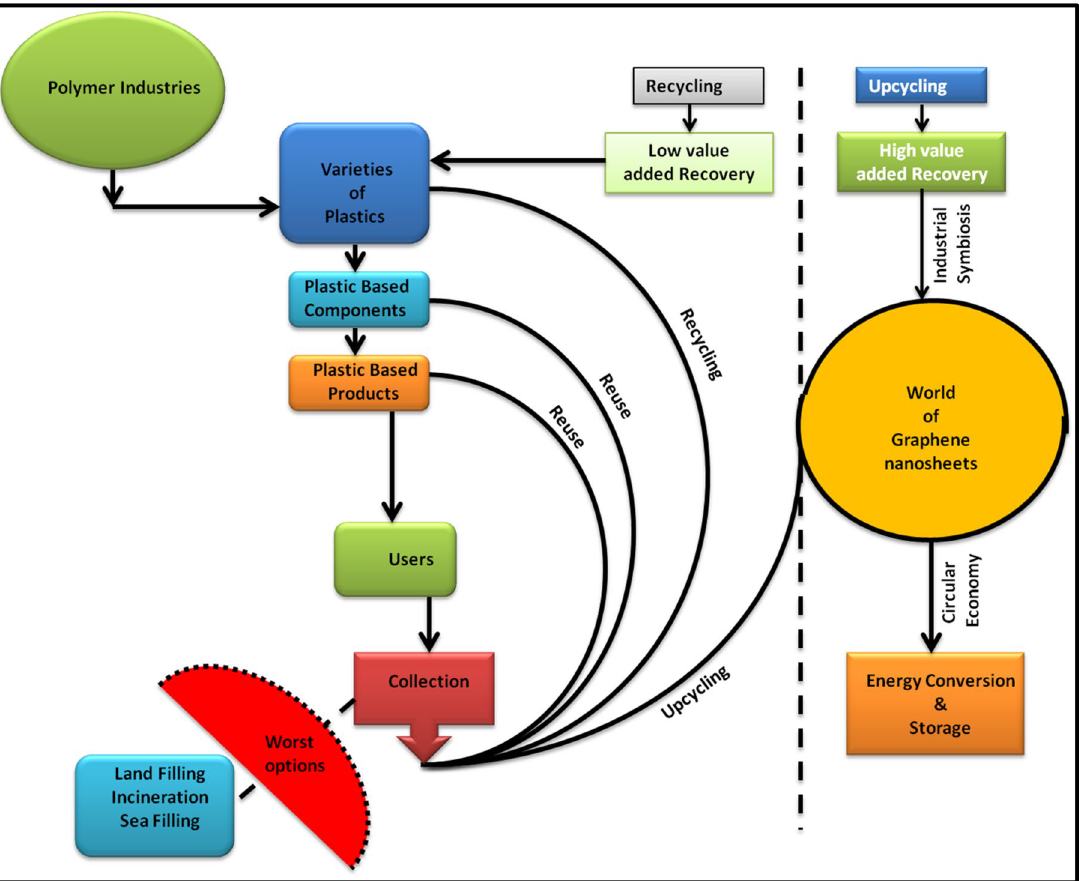
Figure 1. Process flow chart for the waste plastic derived options for circular economy through industrial